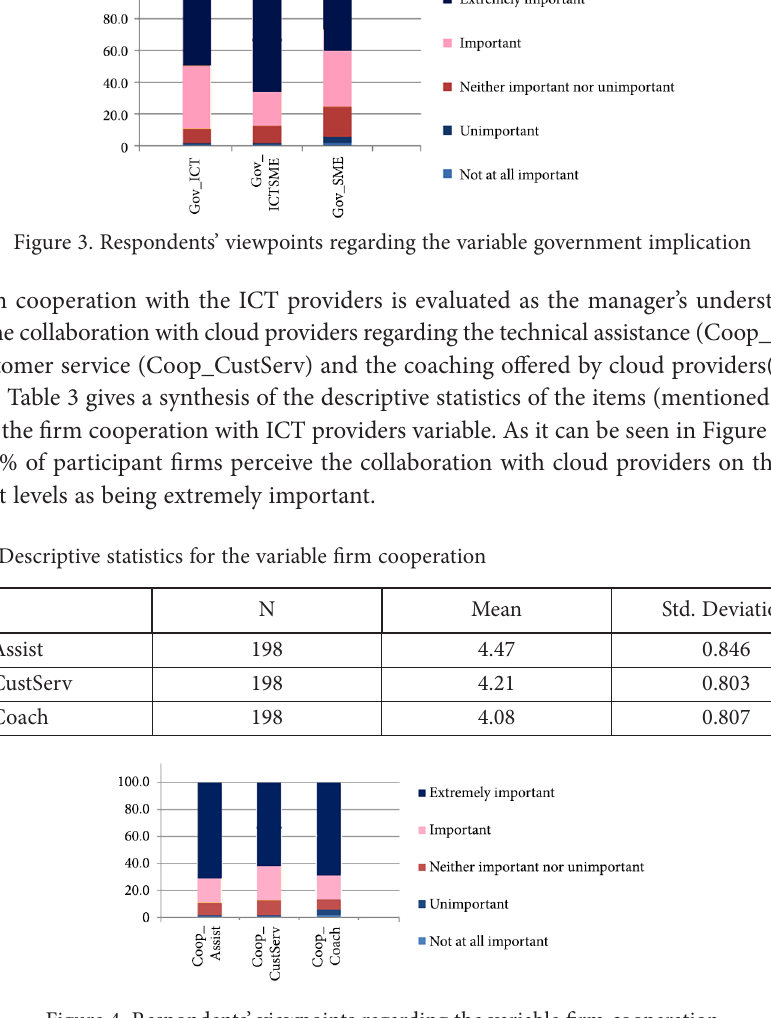
Figure 4. Respondents’ viewpoints regarding the variable firm cooperation